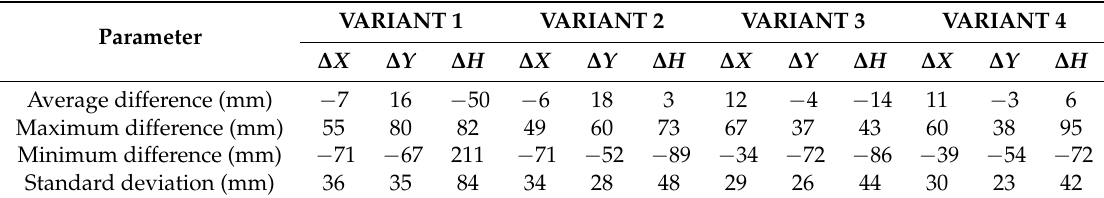
Table 8. Average differences in coordinates and their maximum and minimum values for check points surveyed using static GNSS, compared to an aligned block of photographs.